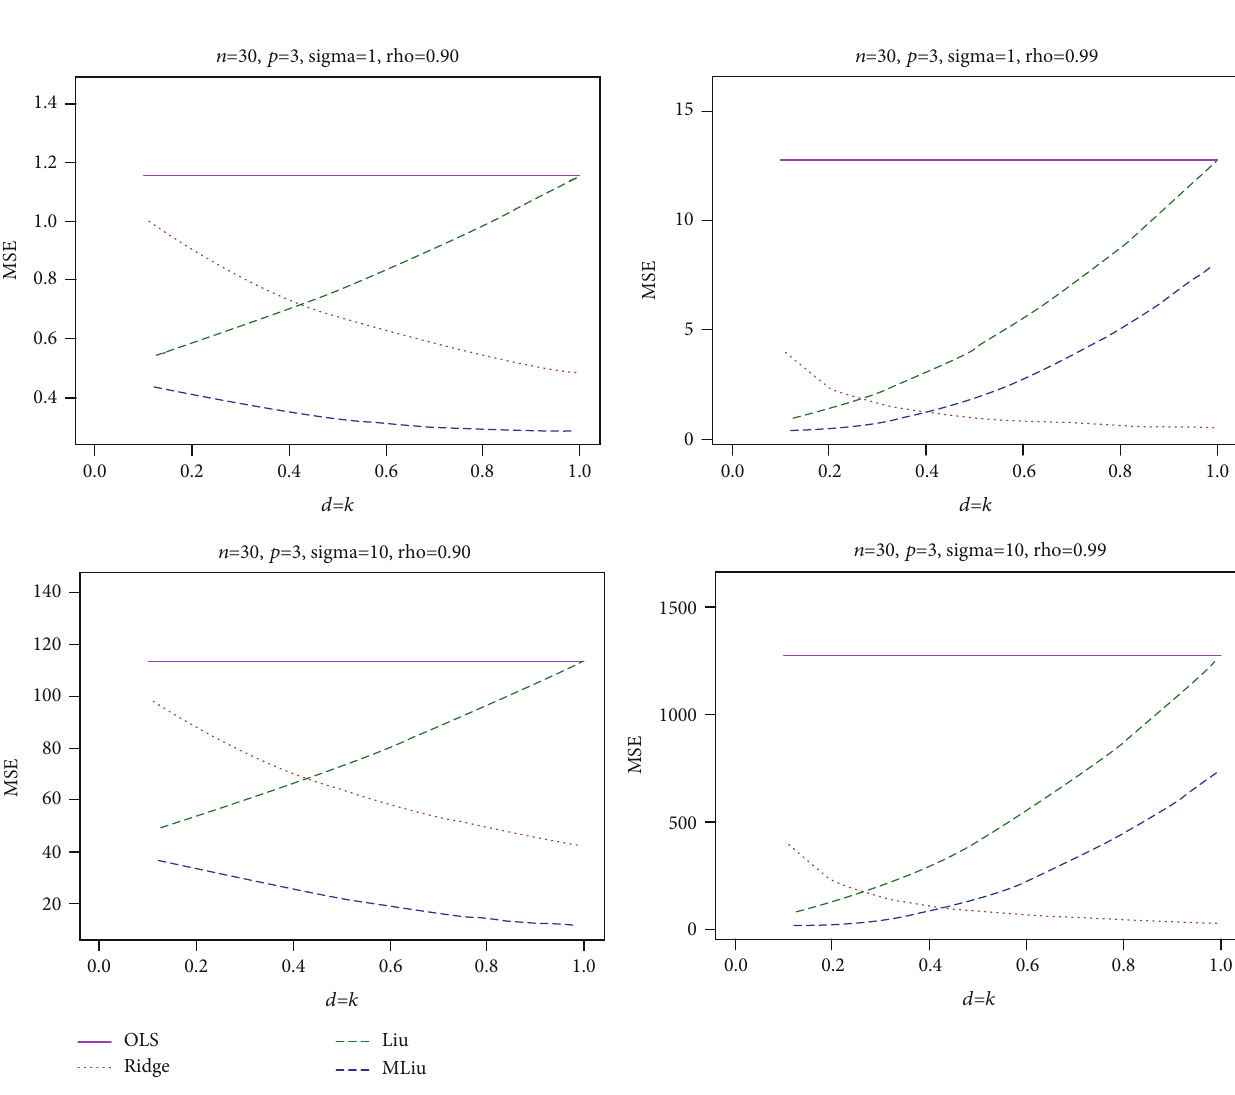
Figure 2: Estimated MSEs for n = 30 . Sigma ð σ Þ = 1 , 10; rho ð ρ Þ = 0 : 90 , 0.99; and di ff erent values of k = d